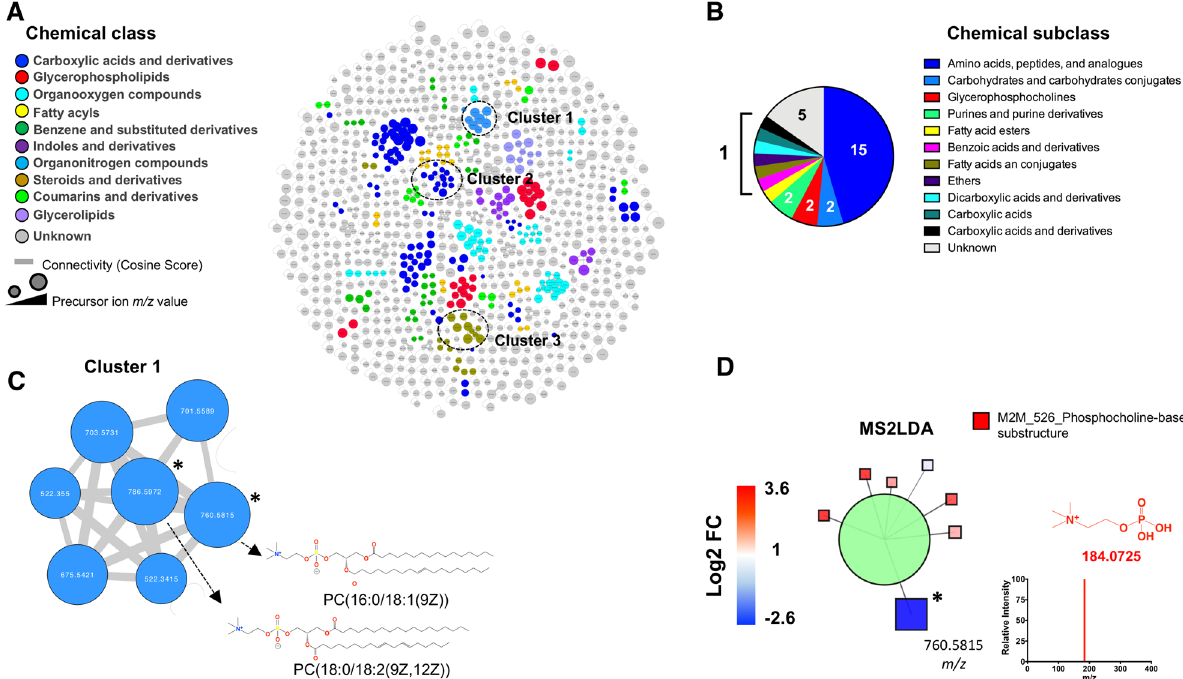
Figure 3. Bovine coronary artery endothelial cells (BCAEC) metabolite molecular network. ( A ) Molecular classes (according to Classyfire) of the metabolome identified by the MolNetEnhancer workflow and visualized by Cytoscape version 3.8.2. Each node represents a unique feature and the color of the node denotes the associated chemical class. The thickness of the edge (connectivity) indicates the MS 2 similarity (Cosine score) among features. The m/z value of the feature is shown inside the node and is proportional to the size of the node. Three selected clusters or connected features as relevant are shown. ( B ) Chemical subclasses (predicted by CANOPUS) of the dysregulated metabolites by simulated diabetes. ( C ) Inset of cluster 1 denoting the presence of phosphocholine (PC)-containing lipids. Significant differential abundant features among simulated diabetes (HG + HI) and control (NG) groups are indicated with an asterisk ( p value < 0.05). ( D ) Characterization of features in ( B ) aided by substructure recognition by MSLDA software using MS 1 visualization in www. ms2lda. org. Fragment at m/z 184.0725 linked to a PC head group by mzCloud in silico prediction (www. mzClo ud. org). Abbreviations: M2M mass2motif, FC fold change, NG normal glucose, HG high glucose, HI high insulin. Chemical structures were drawn by ChemDraw Professional version